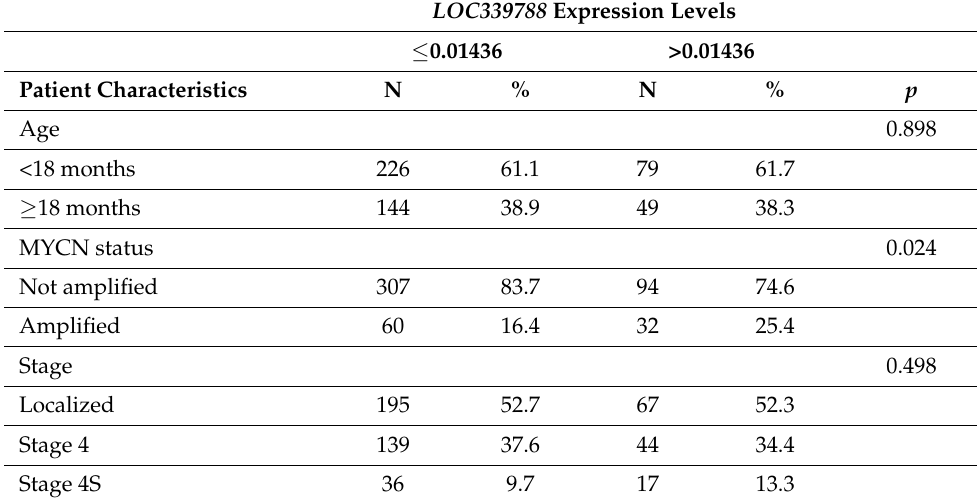
Table 14. Association between LOC339788 expression levels and the main patient characteristics at diagnosis.